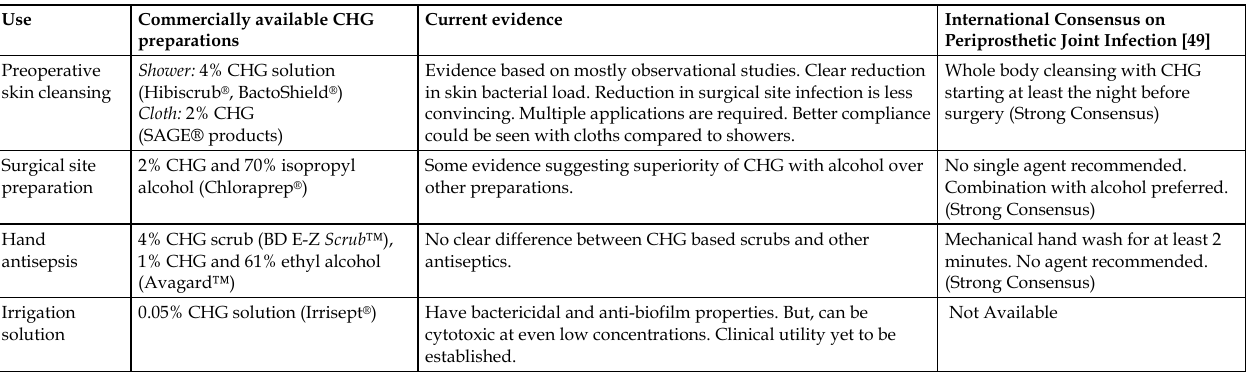
Table 1 . Common applications of chlorhexidine gluconate (CHG) in total joint arthroplasty. Use Commercially available CHG